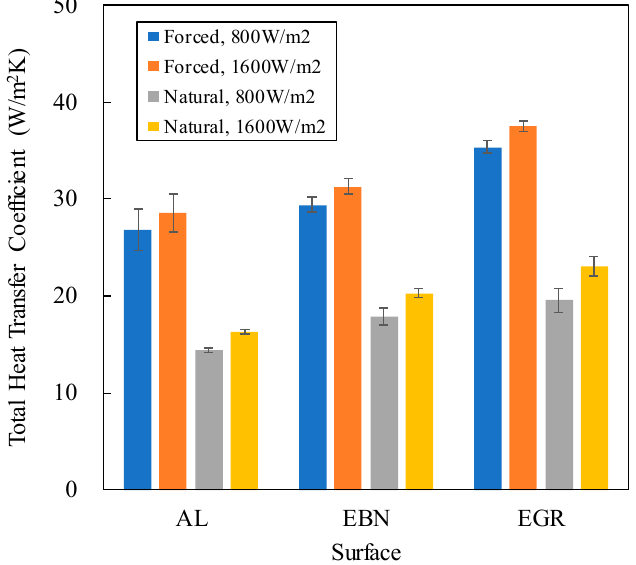
ff ect of surface type on the total heat transfer coe ffi Figure 7. Effect of surface type on the total heat transfer coefficient. Figure 7. E